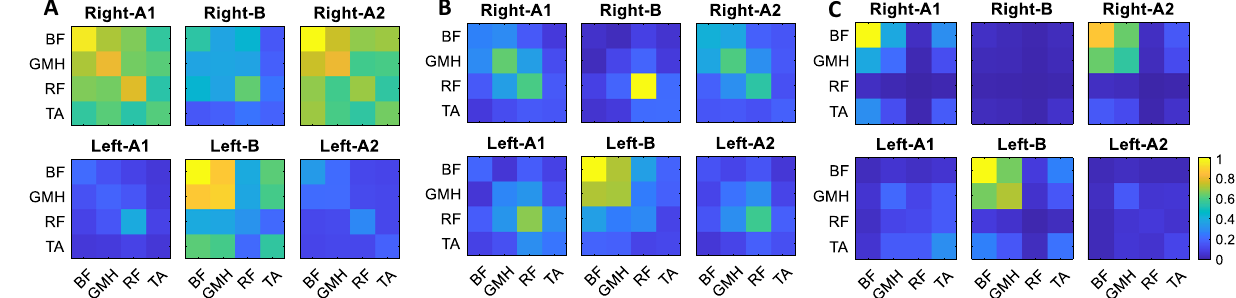
Figure 6. Average muscle activation (co-activation) patterns normalized to the maximum observed muscle activation in each leg separated based on movement direction, leg, and condition for ( A ) LP group, ( B ) HP group, and ( C ) the expert participant. The right leg muscles are more activated/co-activated in A1 and A2 conditions and the left muscles are more engaged in condition B. Muscle activation patterns are different along HP and LP groups. LP group tend to activate/co-activate more muscles (which lead to more bright squares in their checker plot) while the HP group exploit only one or at max two muscle of their leg similar to the expert subject (one square is super bright and the others are almost dark). This can confirm that the HP group participants have converged (learned) to a muscle activation pattern that decreases the muscle